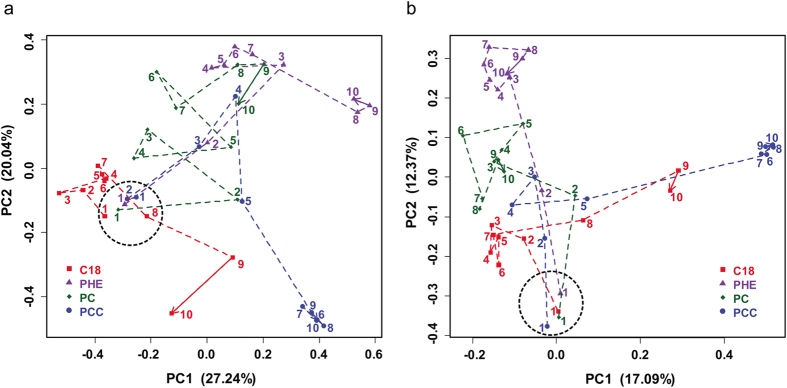
Microbial community succession.Weighted UniFrac (a) and Bray-Curtis (b) distance principal coordinate analysis (PCoA) of microbial communities among the forty consortia in the four treatments. The numbers accompanying the symbols represent the stages of enrichment culture. The directional development of the communities is indicated with arrows.